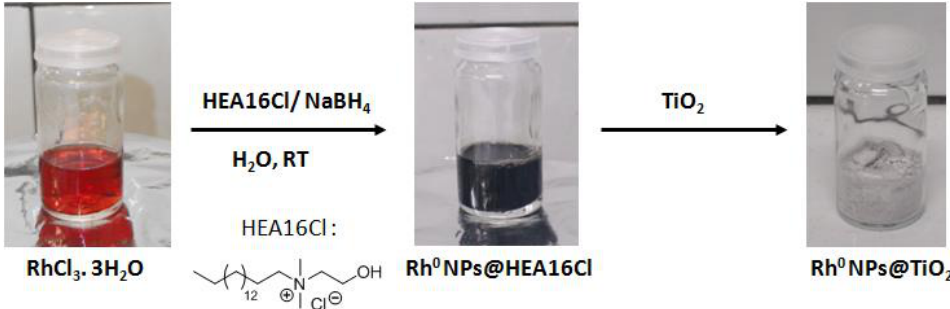
Figure 2. One-pot preparation of Rh 0 NPs@TiO 2 as multicatalytic materials. Furthermore, interplanar distances of 0.352 and 0.233 nm, corresponding to the (101) and (112) lattice planes of anatase, were also observed (Figure 3b magnification).